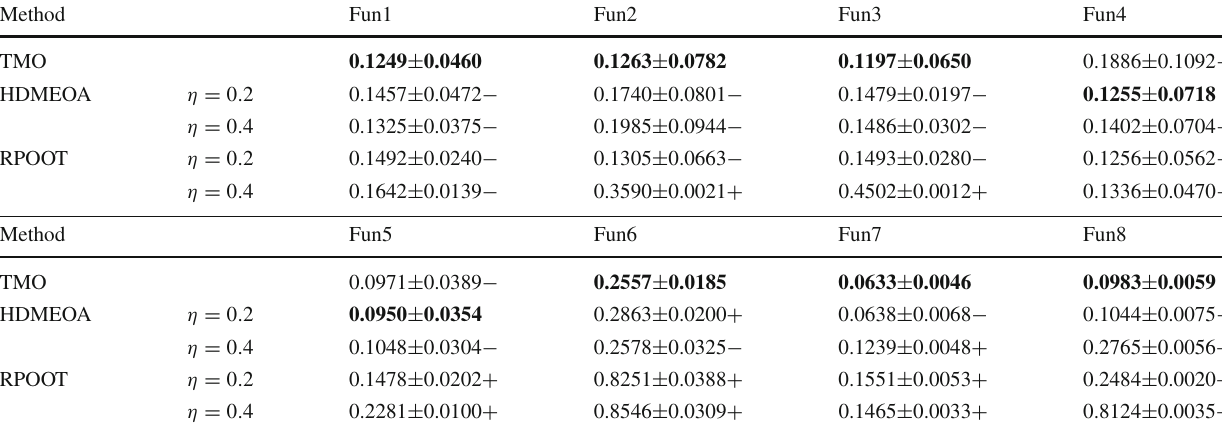
Fig. 6 Survival time comparison of HDMEOA with various δ s under linear environmental changes Table 3 MRIGD comparison of three methods under linear environmental changes